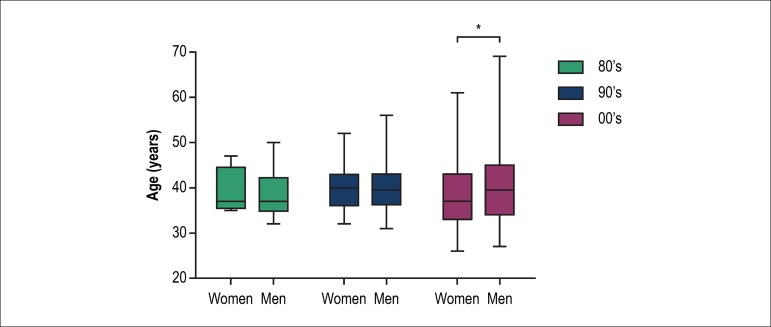
Mean age of the postgraduate students.